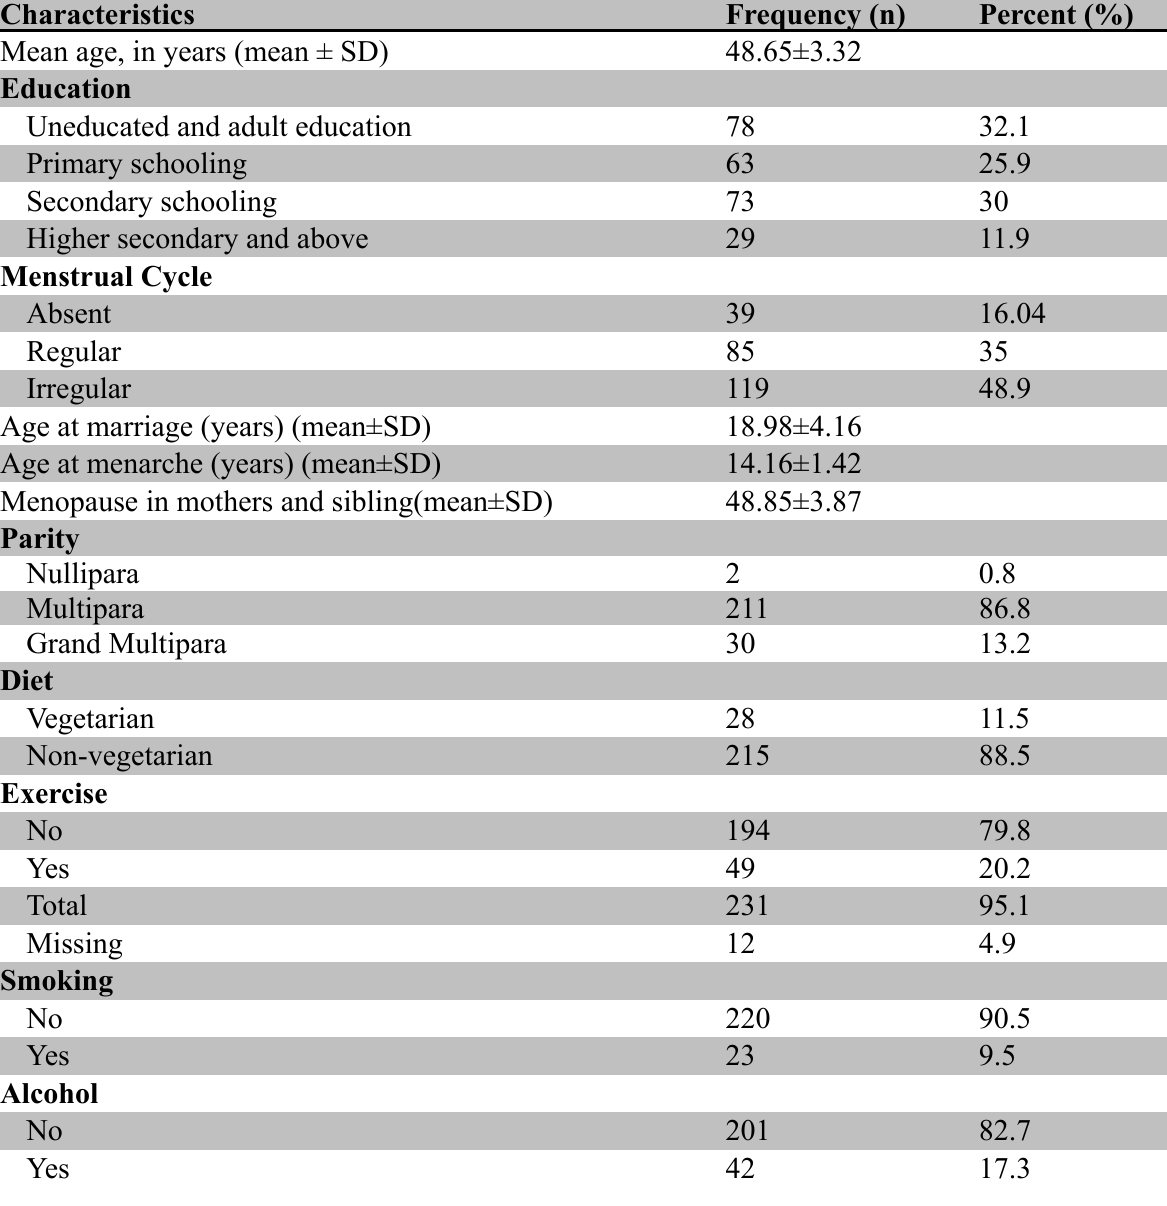
Table 1: Socio-demographic and behavioral characteristics of the study population (n=243)